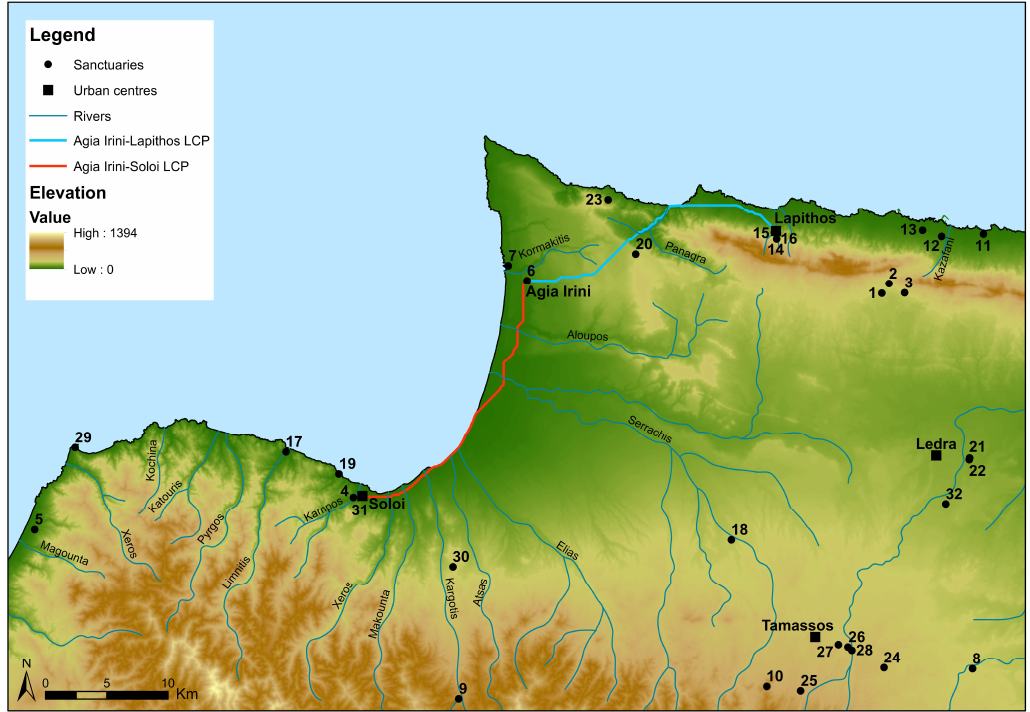
Figure 12. Least Cost Paths Analysis from Agia Irini to Soloi and Lapithos; Digital data courtesy of the Geological Survey Department, Cyprus (by Charalambos